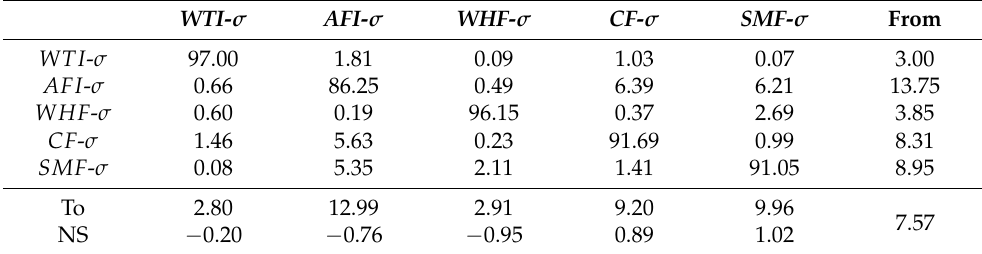
Table 8. Static volatility spillover between crude oil and agricultural futures. WTI - σ AFI -